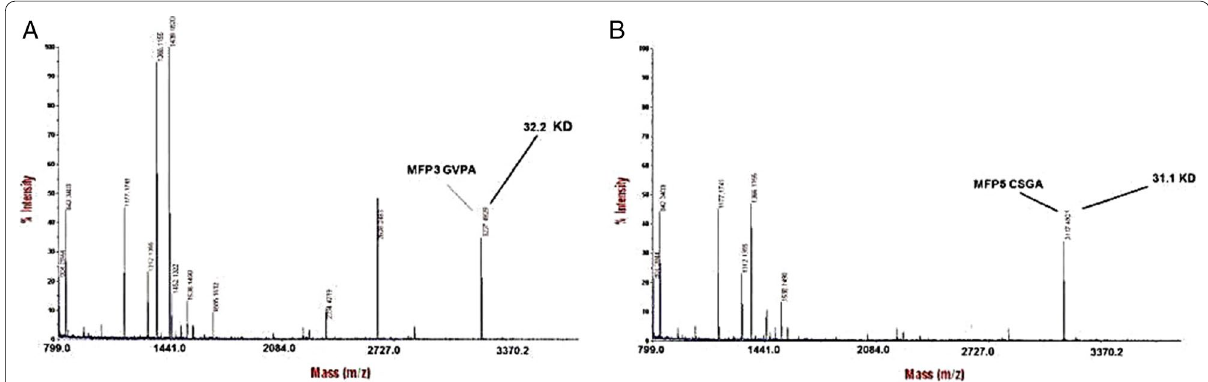
Fig. 4 Purity and molecular weight of the adhesive proteins were determined by MS. MALDI-TOF analysis. Mfp3-GvpA ( A ), Mfp5-CsgA ( B )